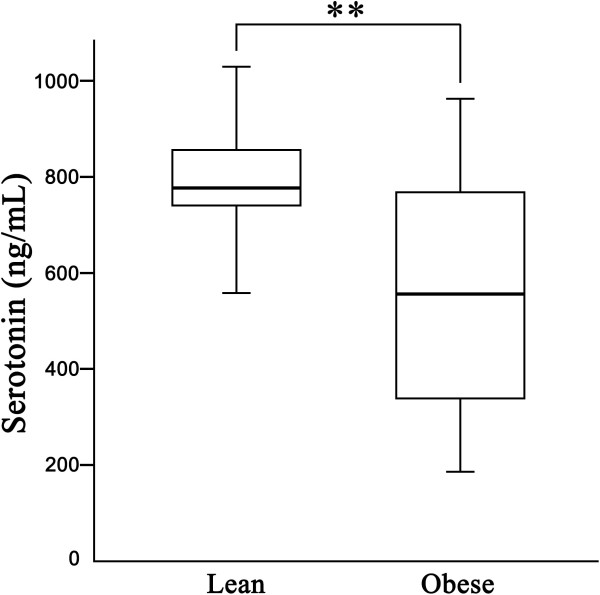
Serotonin concentration between lean and obese groups. Data are presented as boxes and whiskers. Each box includes the interquartile range, whereas the line within a box represents the median, and the whiskers represent the range, extending to a maximum of 1.5 times the interquartile range. Serotonin levels were significantly lower in obese group compared with that of lean group. **p < 0.01: significant difference were observed between lean and obese groups.